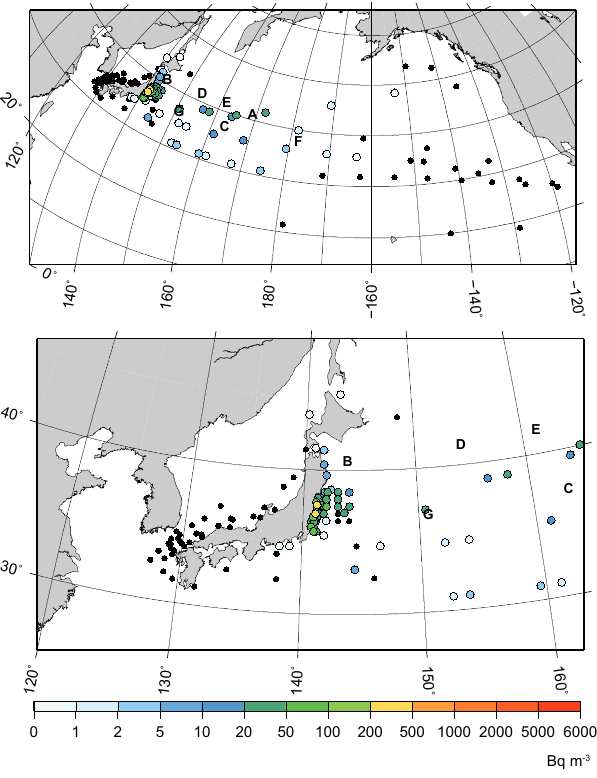
Fig. 4. 134 Cs activity in the surface water during the period from January 2012 to March 2012 for the North Pacific Ocean (upper) and close to Japan (lower). Positions of Argo floats on 15 February 2012 are marked